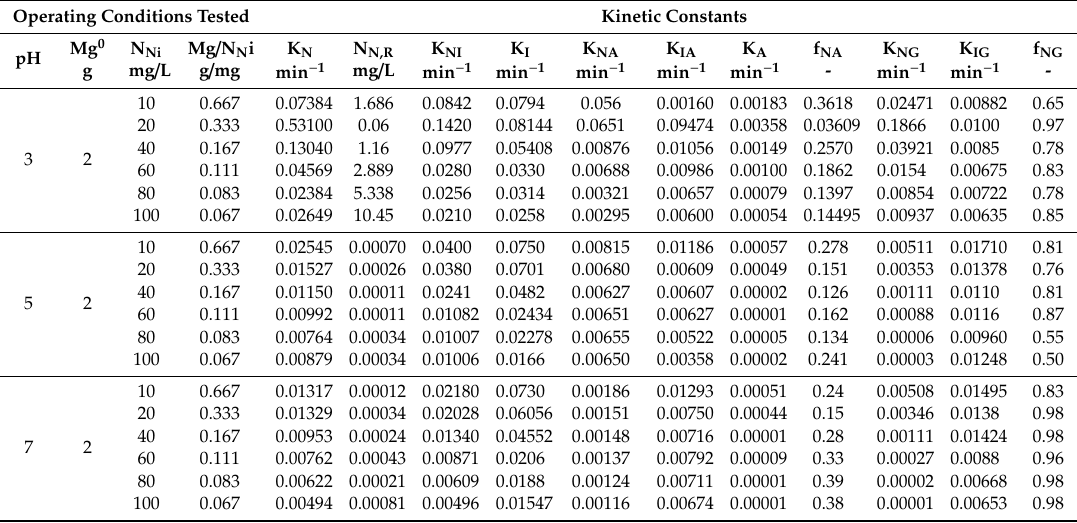
Table 2. Kinetic constants obtained from the interpolation of the experimental curves of tests with Mg 0 = 2 g, varying the pH and the initial N-NO 3 −